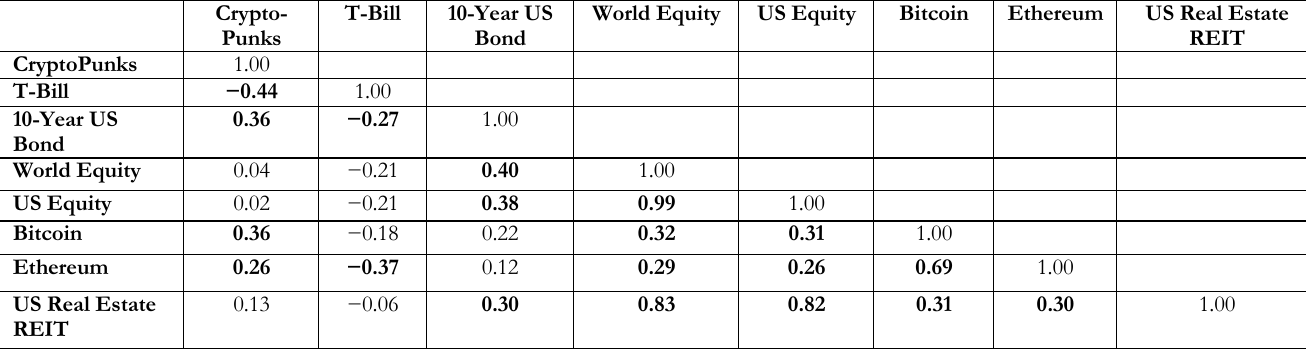
Table 9: Correlation of